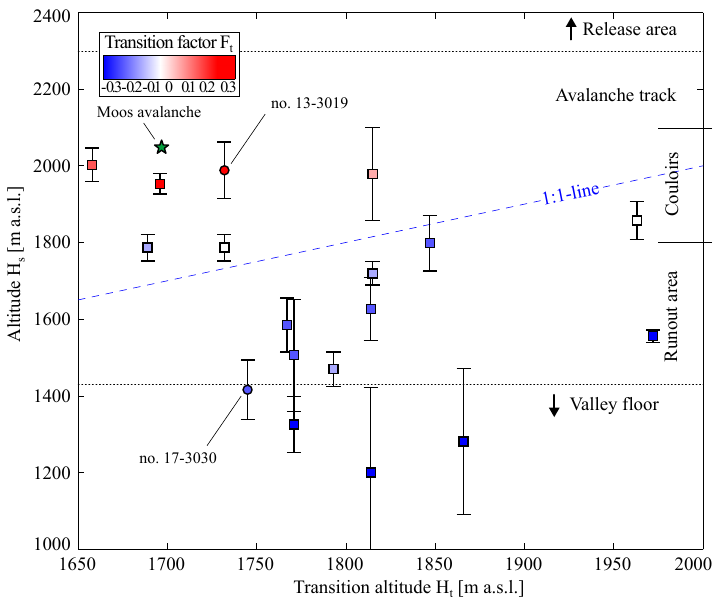
Figure 6. Altitude of transition, H t , against the altitude of the − 1 ◦ C line, H s . The 1 : 1 line (dashed blue) divides the avalanches into cases where the transition occurs above or below the H s line. Horizontal dashed lines and annotations on the right side roughly characterize the VdlS terrain. The colours indicate the transition index from Fig.